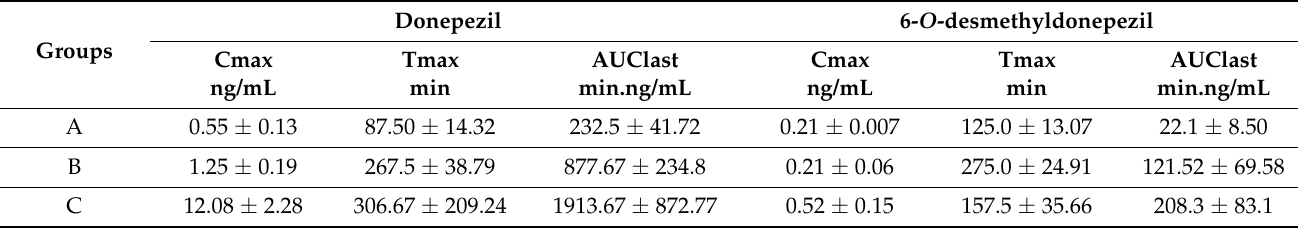
Table 1. Pharmacokinetic parameters. Pharmacokinetic parameters after a single intragastric dose of donepezil (5 or 10 mg; groups A and B), and after a DSS-induced gastrointestinal injury (10 mg of donepezil; group C). All values are expressed as mean ± SEM. Cmax is defined as maximum donepezil or 6- O -desmethyldonepezil plasma concentrations; Tmax is time of Cmax; AUClast means the area under the concentration–time curve from zero time up to the last measured concentration. Donepezil 6- O -desmethyldonepezil Groups